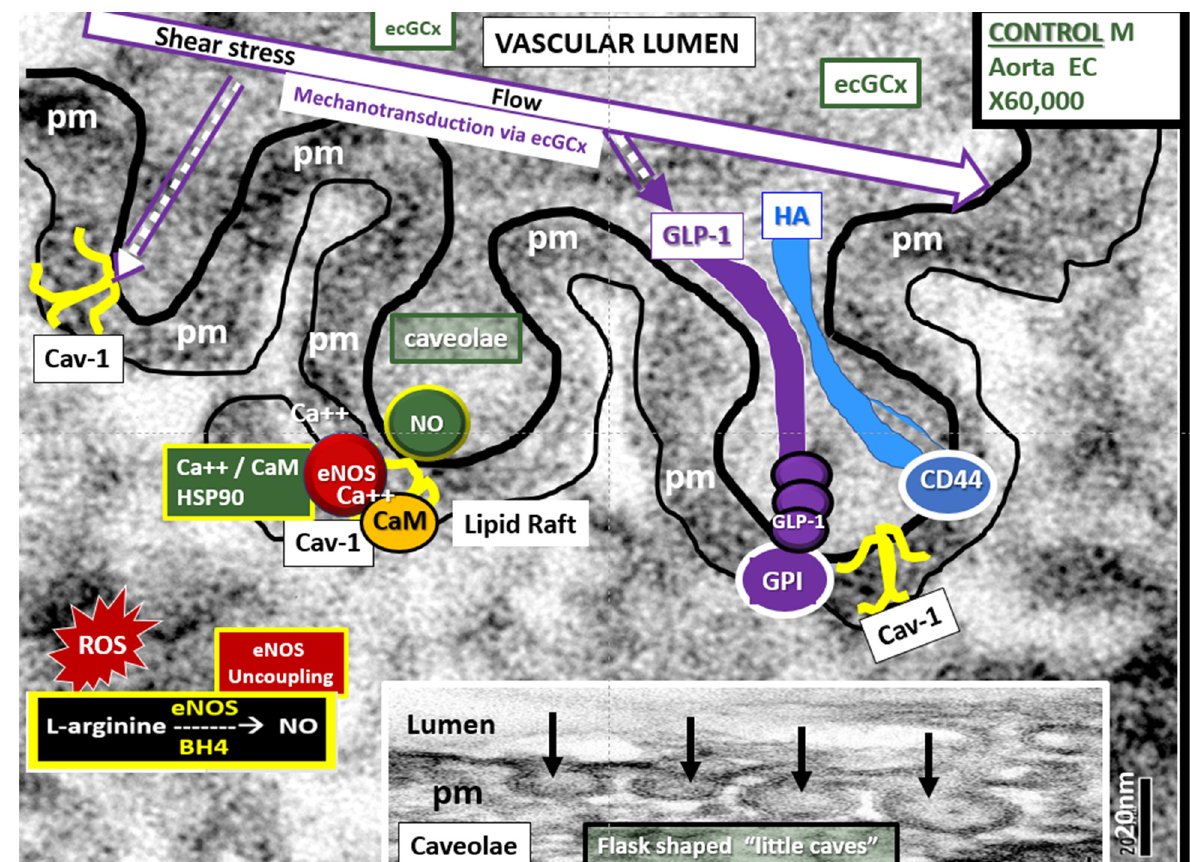
Figure 6. The properties of the endothelial cell glycocalyx (ecCGx) shield and mechanotransduction. These images of the aorta EC illustrate relations among the caveolae, the plasma membrane (pm, lined for clarity), and the ecGCx, with its glypican-1 (GLP-I) anchored to the lipid rafts of the caveolae. Note that the ecCGx extends into the caveolae. The Cav-1 protein is responsible for the omega shape ( Ω ) of the caveolae (yellow icon) (dashed arrow). The shear stress of laminar flow through the ecGCx induces mechanotranduction and release of NO, resulting in vasodilation (open arrow). The ecGCx component glypican-1 is the primary mechano-sensor for shear stress-induced NO production. Scale bar on the left panel is 20 nm and the right-hand panel is an exploded view of left panel. BH4 = tetrahydrobiopterin; Ca++/CaM = calcium calmodulin; Cav- 1 = caveolin-1; GIP = glycosylphosphatidylinositol; GLP-1= glypican-1; pm = plasma membrane.